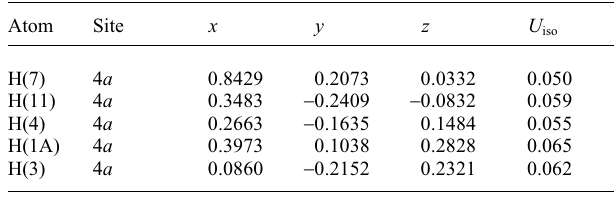
Table 3. Atomic coordinates and displacement parameters (in Å 2 ) .